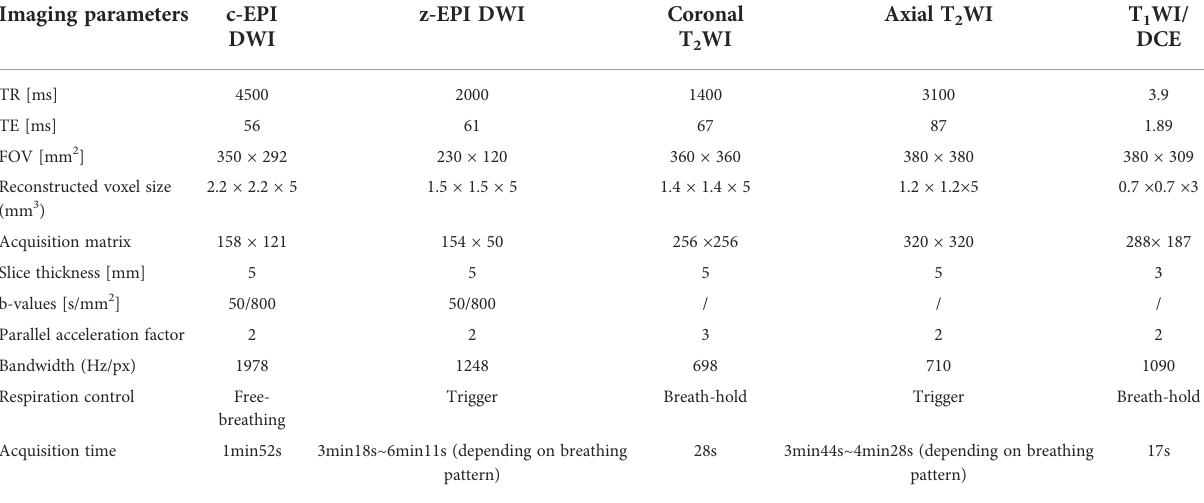
TABLE 1 Magnetic resonance imaging